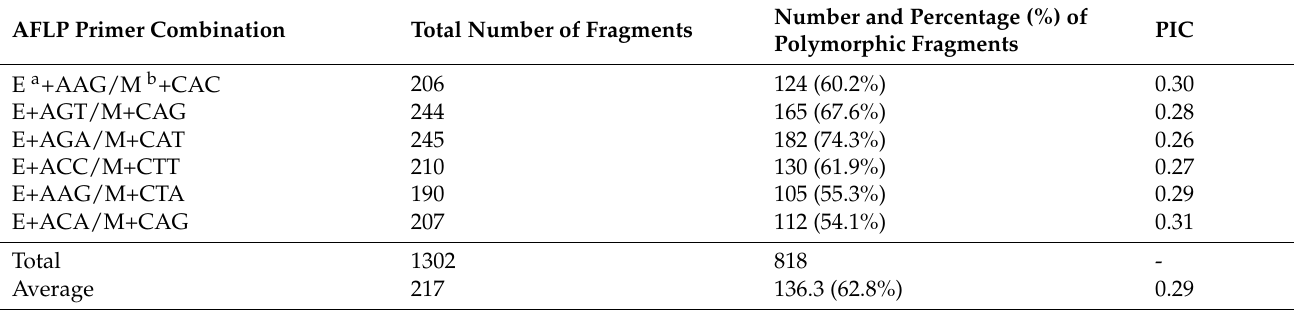
Table 3. AFLP primer combinations, total number of scorable fragments, number and percentage of polymorphic fragments, and polymorphic information content (PIC) per primer combination in 37 F. nilgerrensis plants using AFLP